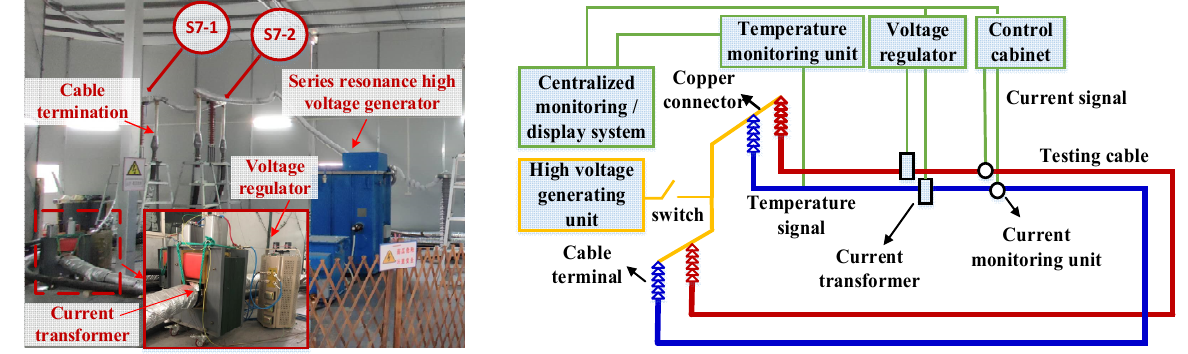
Figure 2. Schematic diagram of the combined electrothermal aging test platform.